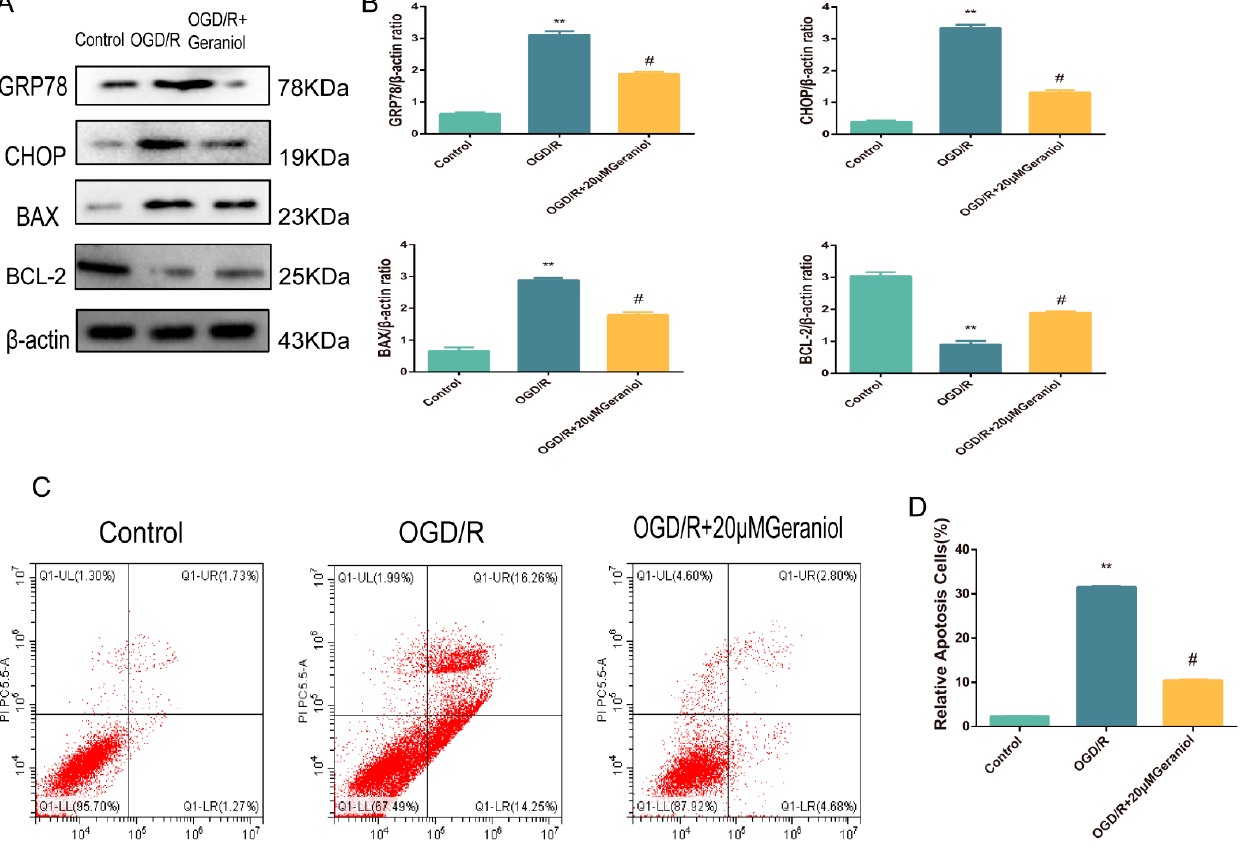
Figure 8. Geraniol reduces endoplasmic reticulum stress and cell apoptosis in oxygen–glucose deprivation/reoxygenation (OGD/R)-induced PC12 cells. ( A , B ) Western blot analysis of GRP78, BAX, BCL-2, and CHOP expression. ( C , D ) Apoptosis detection via flow cytometry. ** p < 0.01 OGD/R group vs. control group, # p < 0.01 OGD/R + 20 µM geraniol group vs. OGD/R group.